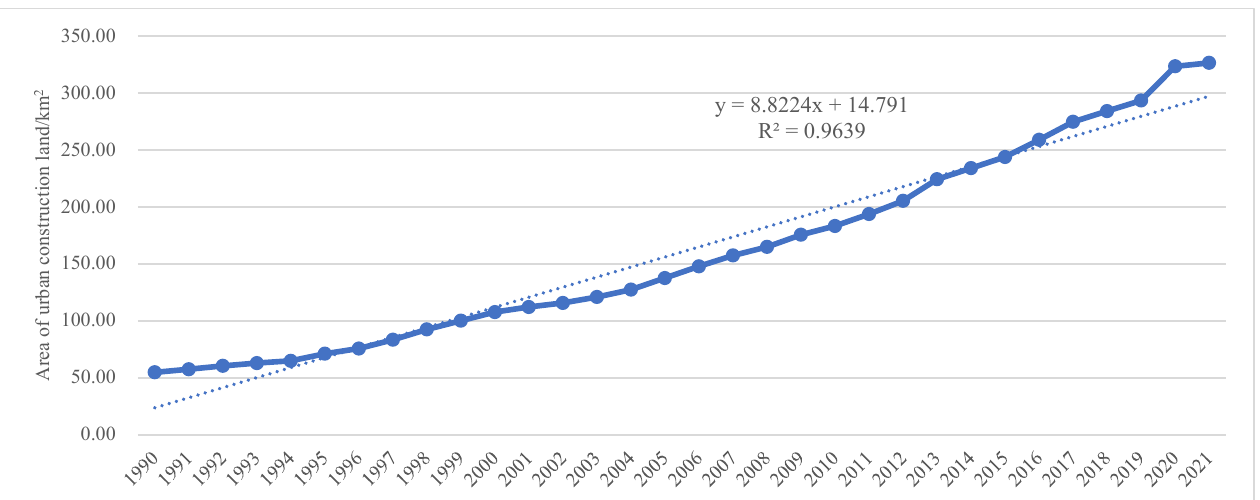
Figure 3. Temporal evolution characteristics of construction land in Nanning from 1990 to 2021.